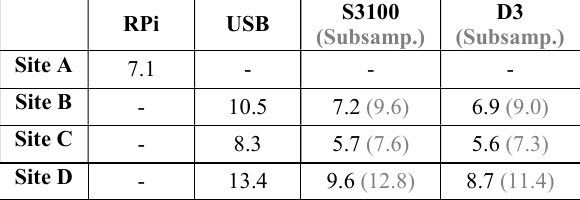
Table 2. Average GSD of the acquired images (in mm).